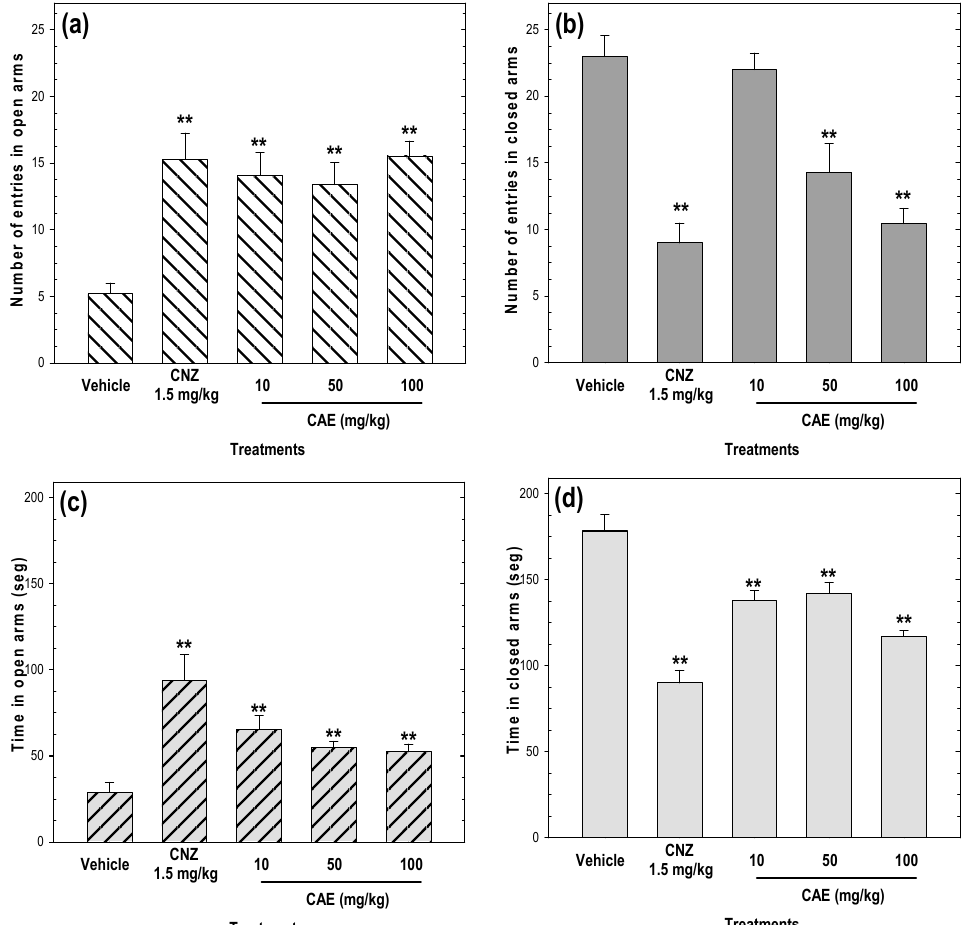
Figure 4. Anxiolytic-like effects of CAE (10–100 mg/kg p.o.) measured by the number of entries in open ( a ) and closed ( b ) arms and the time spent in open ( c ) and closed ( d ) arms and in the elevated plus maze during a 5 min exposure. Clonazepam (CNZ) at 1.5 mg/kg p.o. was used as the positive control. Bars represent mean values (± SEM) for the experimental group. n = 8, ** p < 0.05 compared to the vehicle group.